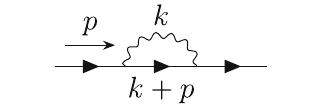
Fig. 1 Fermion self-energy diagram, with the virtual emission and reabsorption of a boson, that would appear in the absence of f -type or c -type Lorentz violation